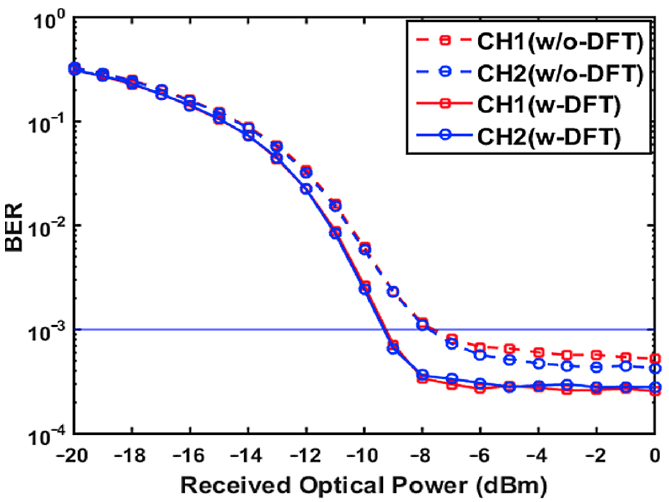
Figure 5. BER versus received optical power over a 25 km SSMF IMDD PON transmission system when a 7-bit resolution is considered.